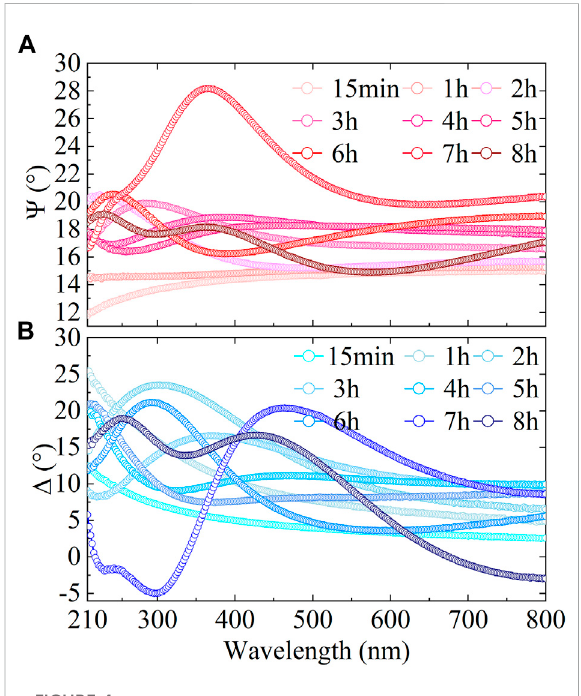
FIGURE 4 Ellipsometry data of DLC fi lms with deposition time. (A) Ψ spectra of DLC fi lms (B) Δ spectra of DLC fi